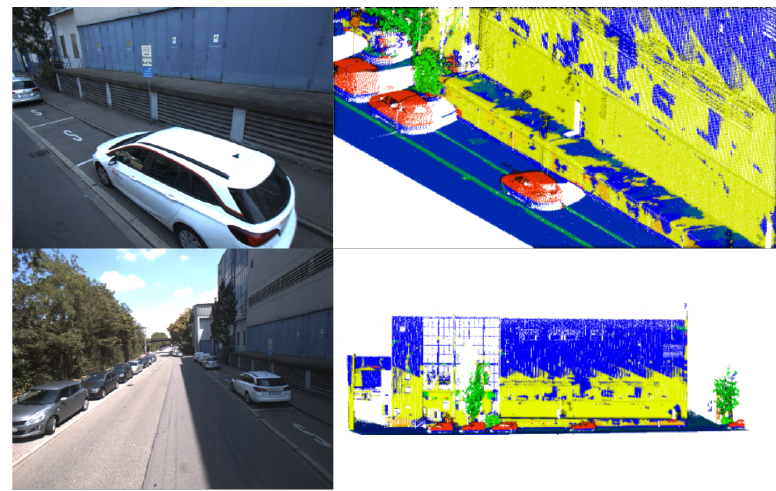
Figure 14. Original image ( left ), semantic segmentation produced by DL approach ( right